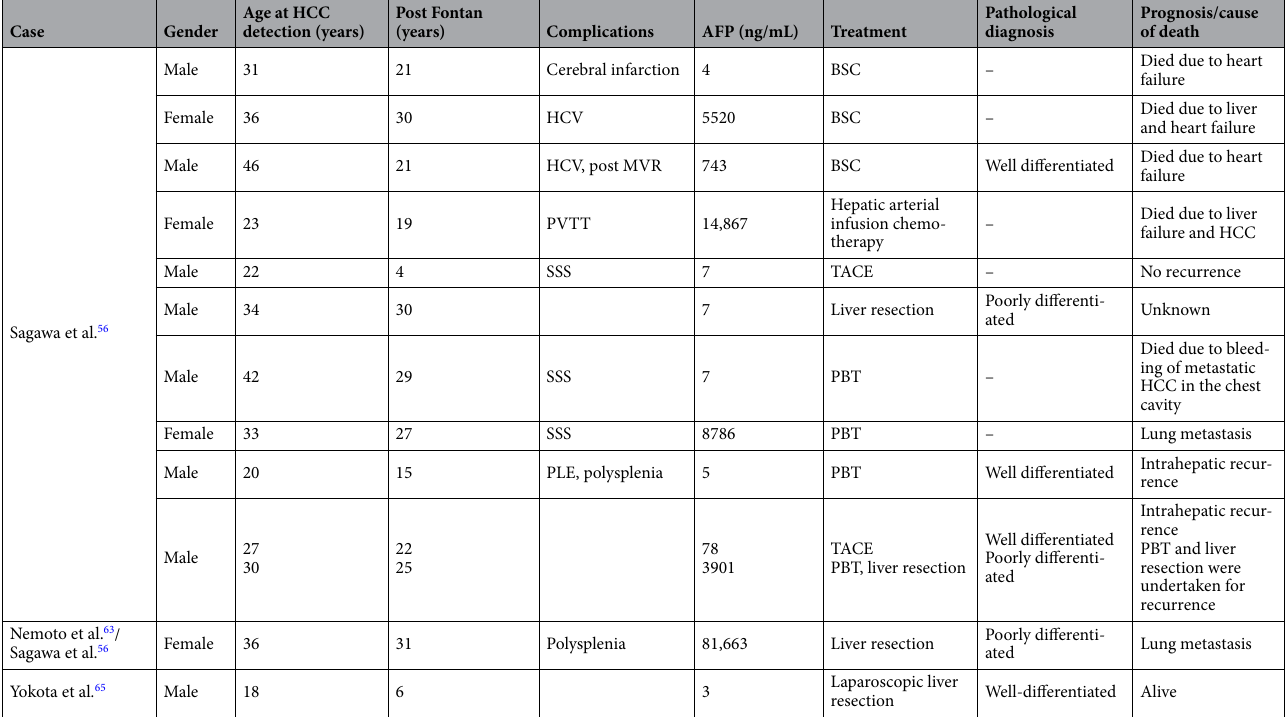
Table 4. Characteristics of patients with Fontan-associated liver disease-hepatocellular carcinoma (FALD- HCC). AFP alpha fetoprotein, ASD atrial septal defect, BSC, best supportive care, CHLT combined